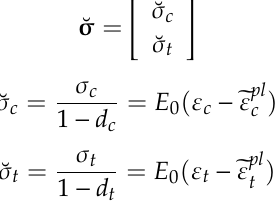
Figure 14. 3D skeleton diagram ( a ) and schematics of sample specimen ( b ) for uniaxial quasi-static simulation.